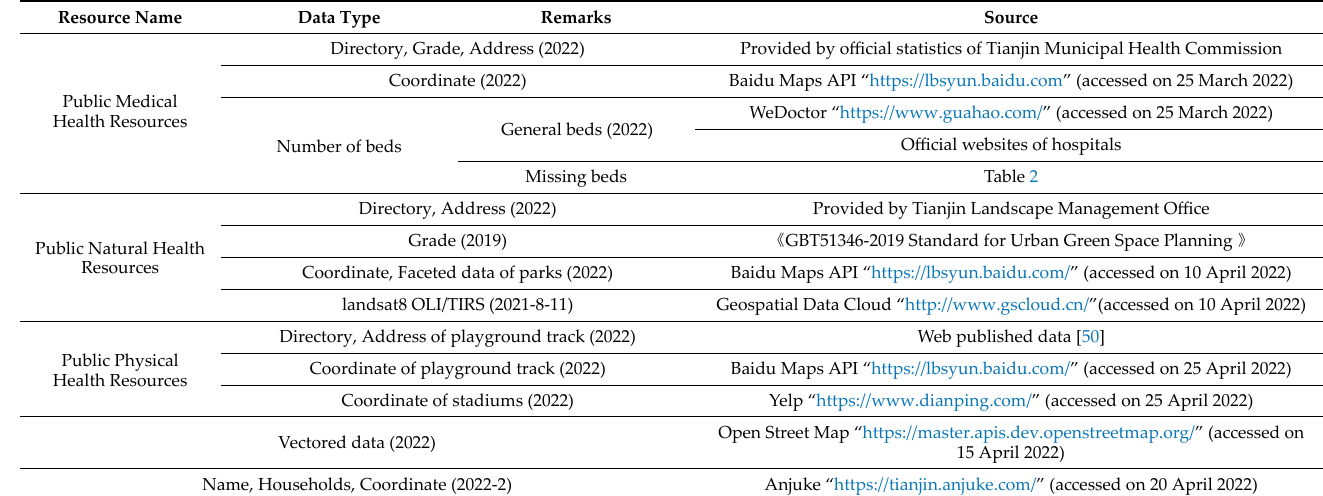
Table 1. Data sources of urban public health resources in the central urban area of Tianjin.